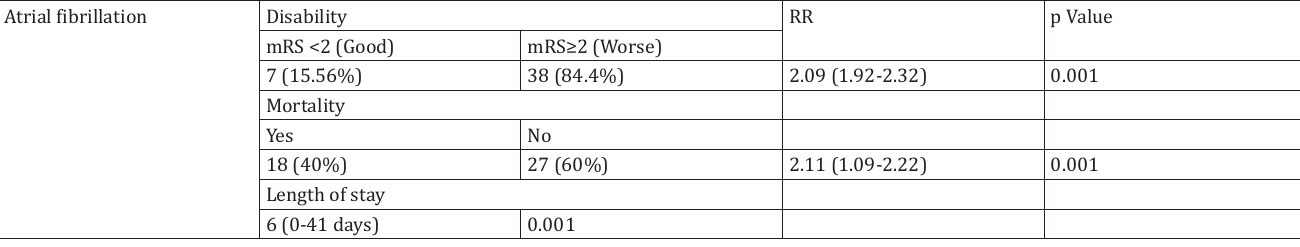
Atrial fibrillation (-)